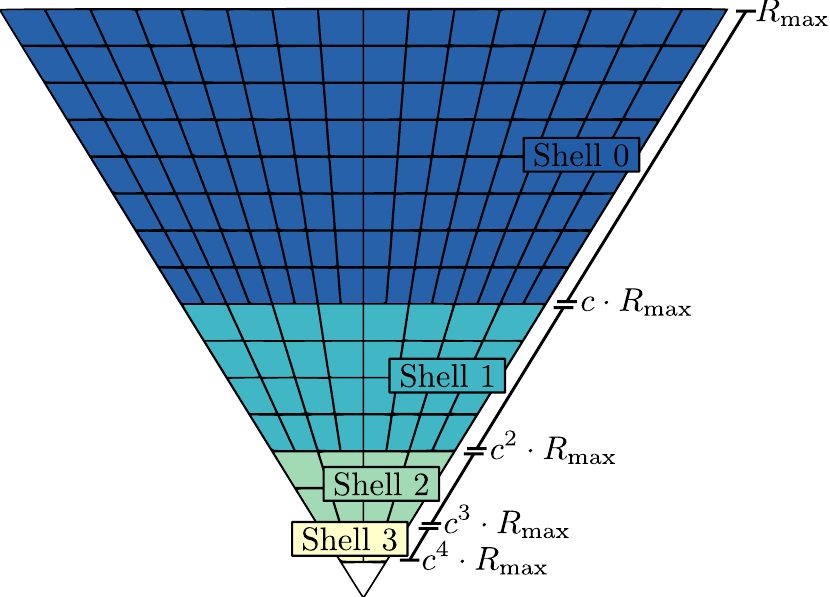
Figure 11. Radial splits of central layers divide the grid into regular regions that represent spherical shells. At refinement level k , there are k − 1 shells and the central layer. These shells are similar, but have a different number of cells and should, therefore, have a mapped volume proportional to the number of cells they